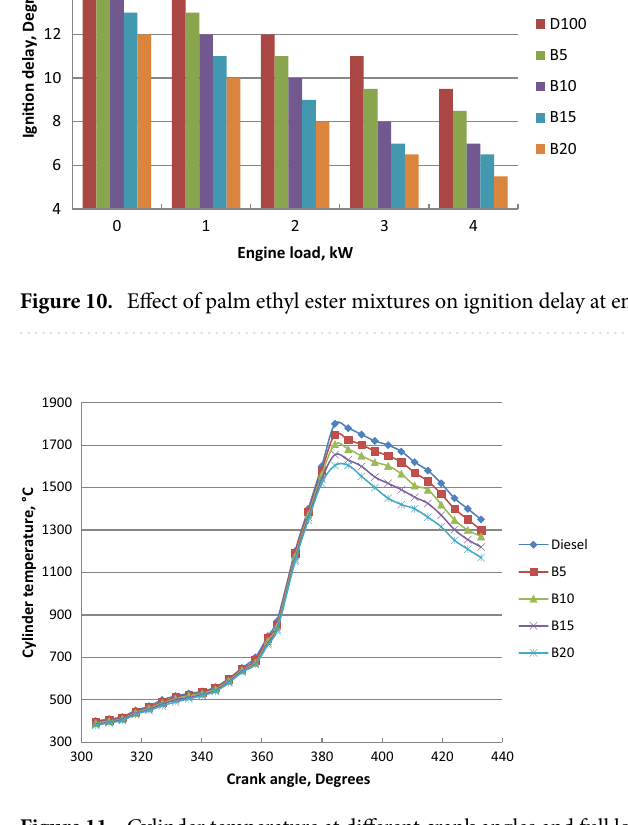
Figure 11. Cylinder temperature at different crank angles and full load for biodiesel